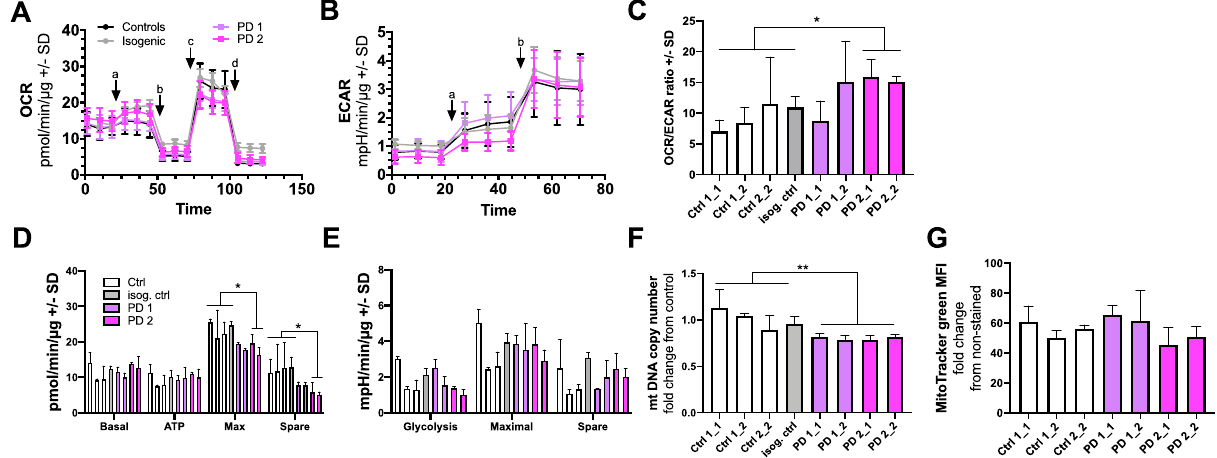
Figure 5. PD astrocytes have altered metabolic profile. ( A ) Oxygen consumption rate (OCR) following additions of 10 μM glucose ( A ), 1 μM oligomycin ( B ), 1 μM FCCP ( C ), and 1 μM antimycin A and rotenone ( D ) in astrocytes. ( B ) Extracellular acidification rate (ECAR) following additions of 10 μM glucose ( A ) and 1 μM oligomycin ( B ). Results are normalized to protein content and shown as mean ± SD from three independent experiments. ( C ) The OCR/ECAR ratio calculated after glucose addition. ( D ) Calculated OCR values of basal respiration, ATP production, maximal respiration, and spare respiratory capacity. ( E ) Calculated ECAR values of glycolysis, maximal glycolysis, and spare glycolytic capacity. ( F ) mtDNA copy number measured from astrocytes. Results are shown as relative fold change to healthy cells. ( G ) MitoTracker green Mean Fluorescence Intesity (MFI) per cell, representing mitochondrial mass. Bars represents mean ± SD, *p < 0.05, **p < 0.01. The order of lines in ( D ) and ( E ) is the same as in ( C